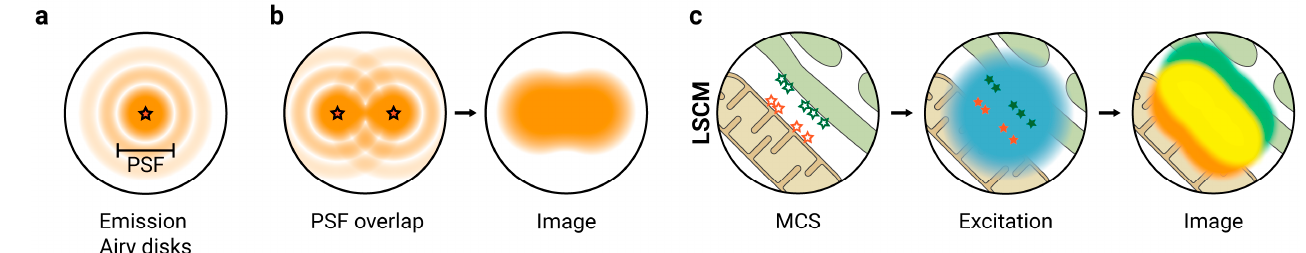
Figure 2. Principles and limitations of optical light microscopy. ( a ) When the light emitted by a fluorophore interacts with the microscope, it is diffracted in a pattern called Airy disks. This diffraction blurs out any light emitted by a single fluorophore to a certain minimal size bigger than the emitter, known as the Point Spread Function (PSF); ( b ) if the distance between two fluorophores is too small, their PSFs overlap and the fluorophores are seen as a single object in the resulting image and cannot be resolved; ( c ) in laser scanning confocal microscopy (LSCM), all excited fluorophores emit light simultaneously, and their PSFs overlap. Thus, LSCM resolution is limited by diffraction, and MCS structures cannot be easily distinguished. Lateral resolution > 200 nm; axial resolution > 500 nm. Table 1. Main characteristics, advantages, and limitations of SRFM techniques applied to the study of MCS.